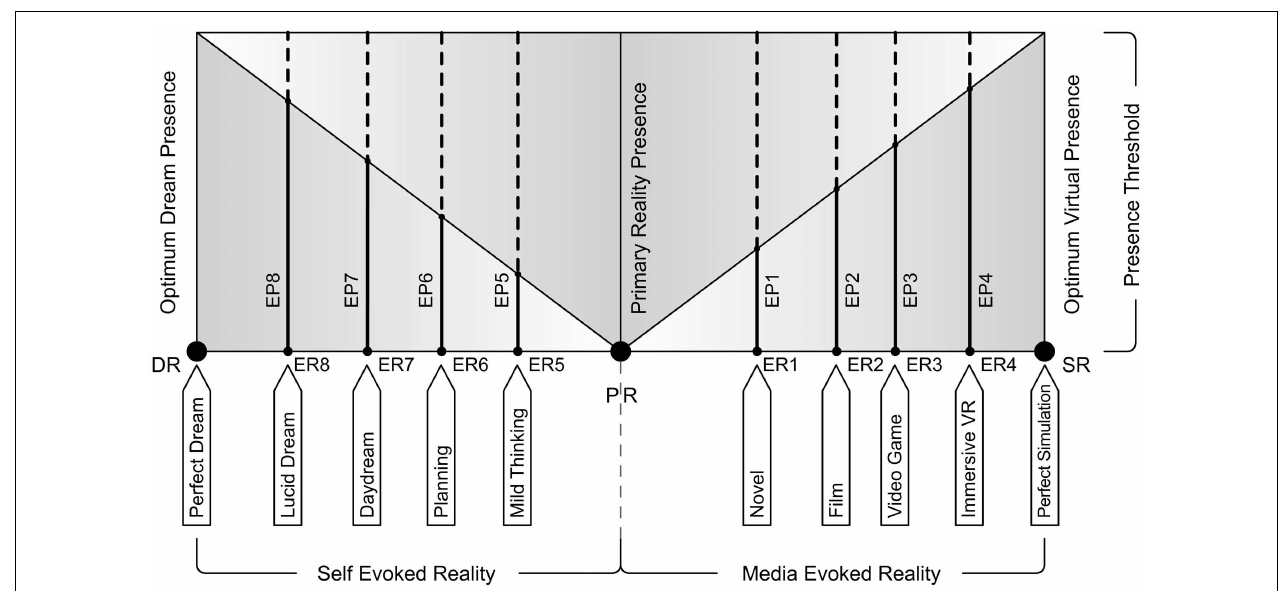
FIGURE 7 |An example range of Media-ER and Self-ER experiences mapped on reality-presence map, for an individual, that would occur at various points in